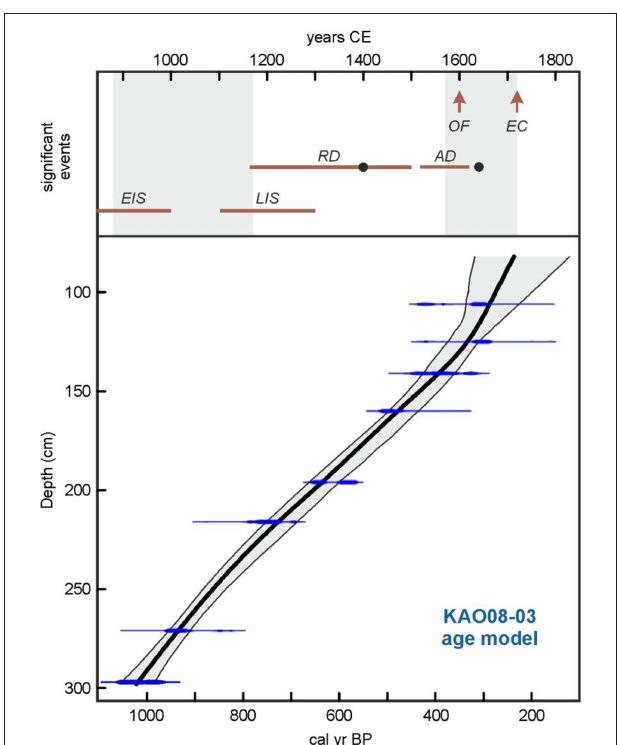
FIGURE 9 | Age-depth model of core KAO08-03 using the smooth-spline option. See text and Table 1 for more details. The upper part of the figure shows some significant events discussed in the text. Gray bands are the droughts recorded at Rano Raraku (Cañellas-Boltà et al., 2013). EIS, Proposed range for early island settlement (Flenley and Bahn, 2003; Vargas et al., 2006); LIS, proposed range for late island settlement (Hunt and Lipo, 2006; Wilmshurst et al., 2011); RD, Rano Raraku deforestation (Cañellas-Boltà et al., 2013), the black dot indicates the first evidence of cultivation (Horrocks et al., 2012a); AD, Rano Aroi deforestation (Rull et al., 2015), the black dot indicates the first evidence of cultivation) (Horrocks et al., 2015); OF, Foundation of the ceremonial village of Orongo (Robinson and Stevenson, 2017); EC, European contact. livestock (Leeming et al., 1996; Bull et al., 2002; D’Anjou et